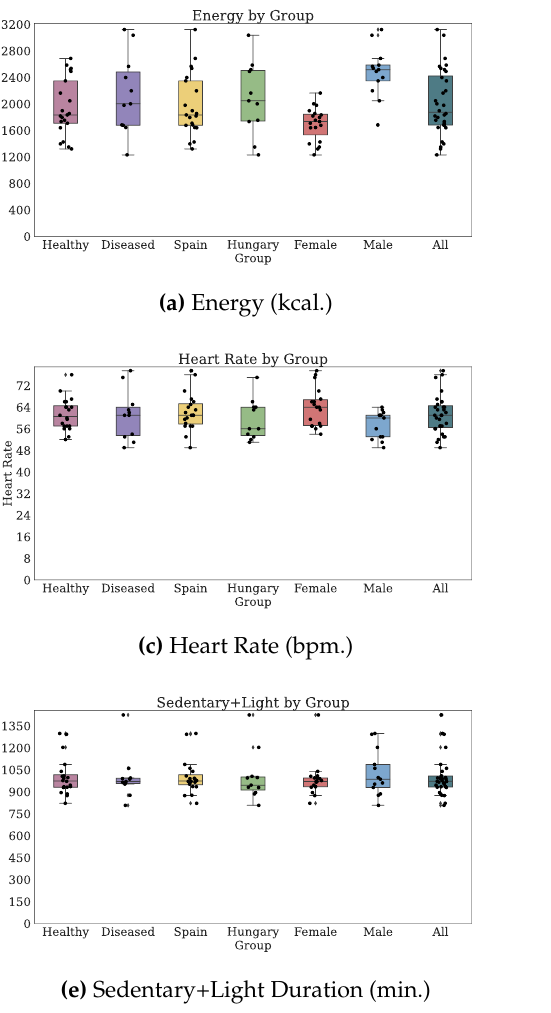
Figure A16. Median values of TechROs (Fitbit) across the entire monitoring period: energy, steps, heart rate, sedentary duration, sedentary+light duration, light duration (1 of 2)